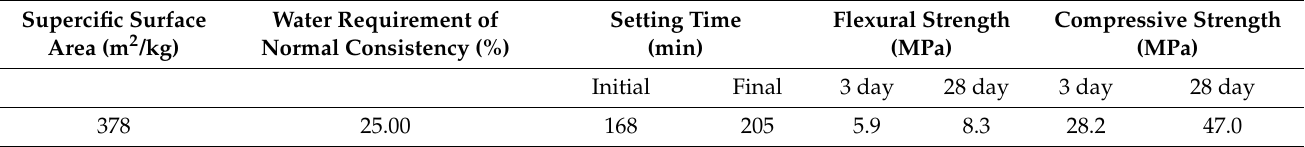
Table 2. Physical properties of